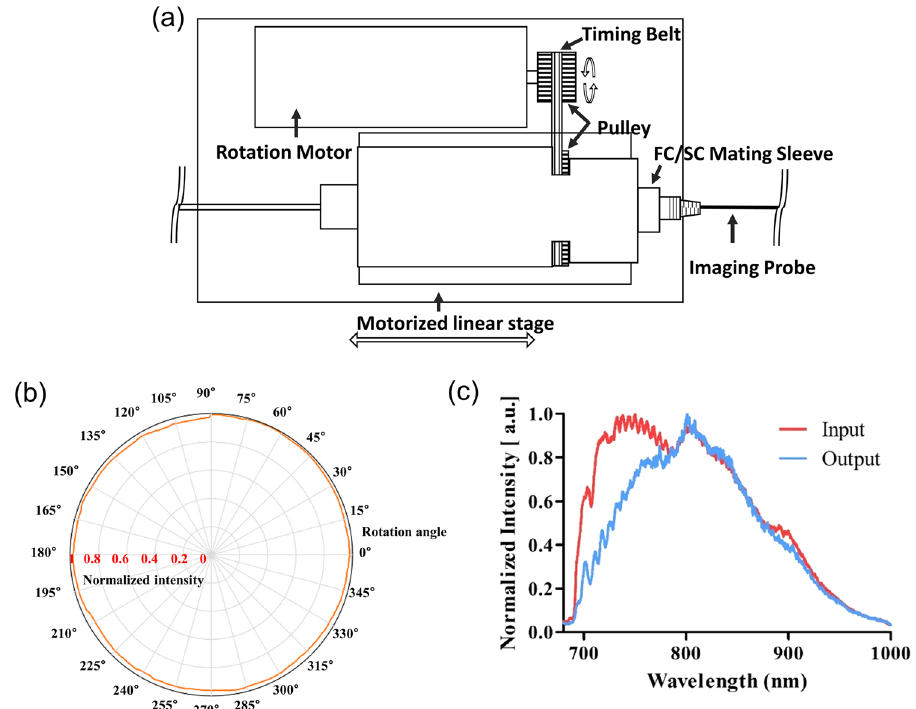
Figure 2. ( a ) Schematic diagram of the developed rotary joint and pullback stage for three-dimensional vascular imaging; ( b ) Experimental results of the normalized optical power throughput depending on the rotational angle of the rotary joint; ( c ) Experimental results of the spectral throughput of the rotary joint over the entire wavelength of the designed light